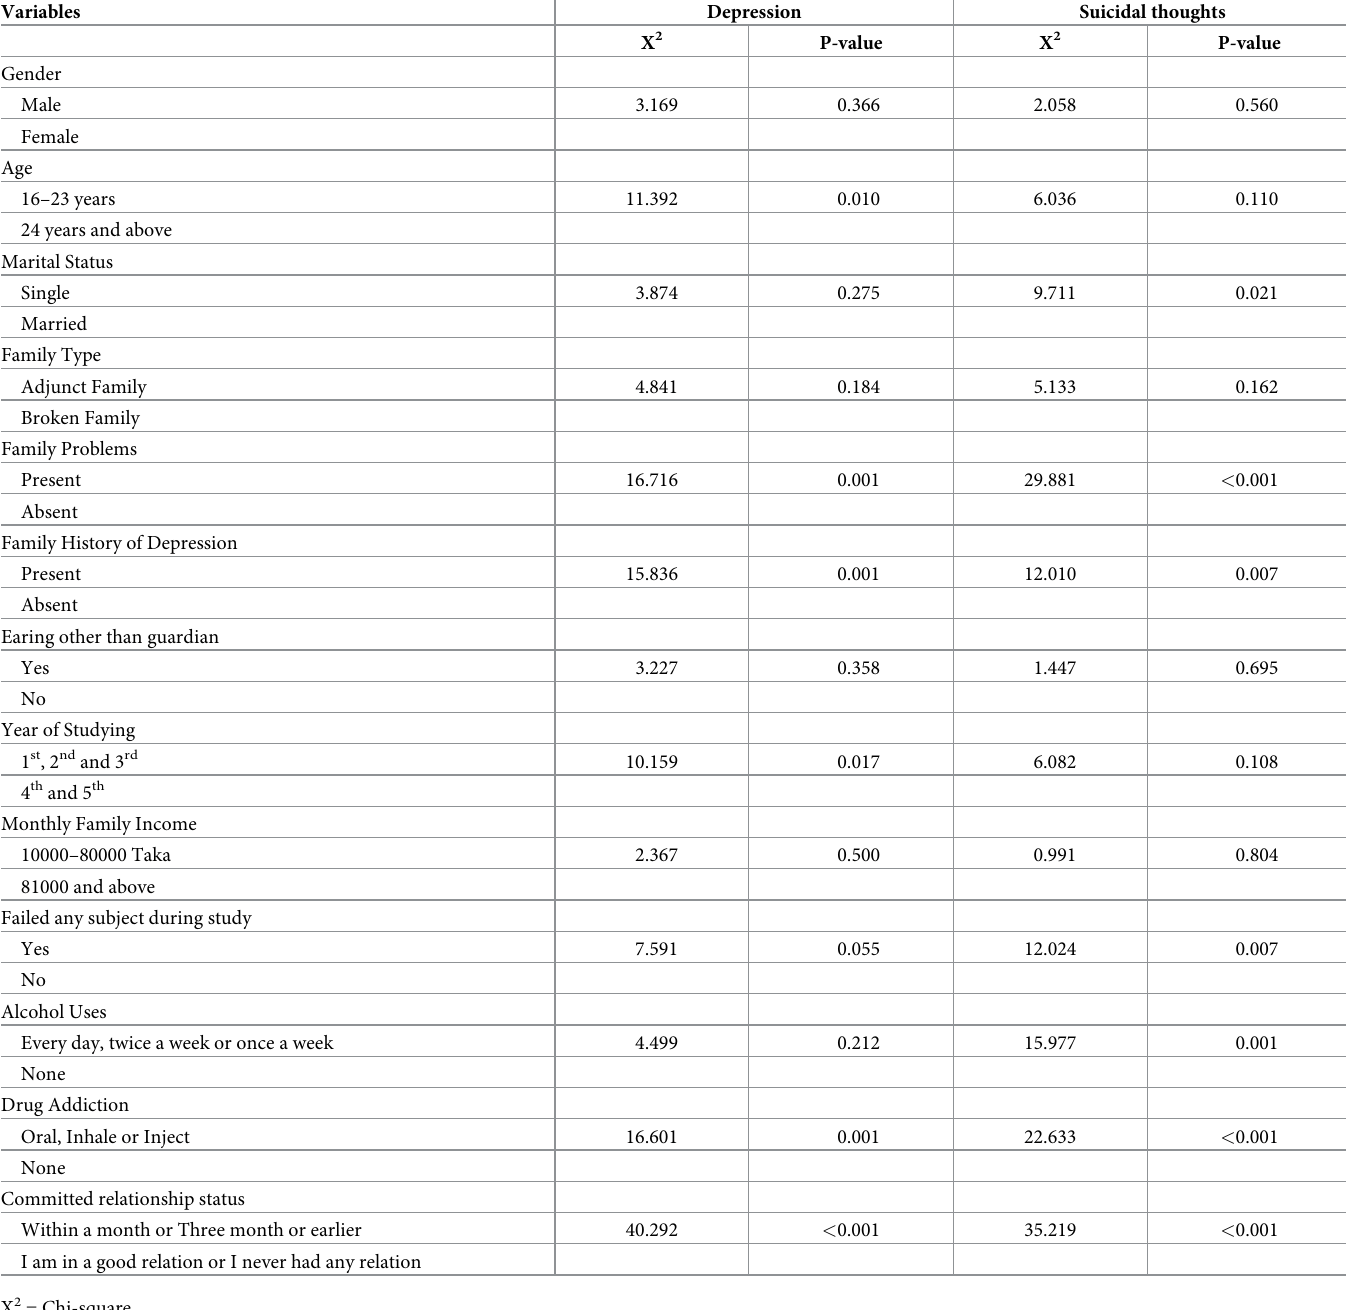
Table 2. Prevalence of depression and suicidal ideation according to associated factors among medical students of Enam Medical College & Hospital, Savar, Dhaka, Bangladesh, 2020 (n =